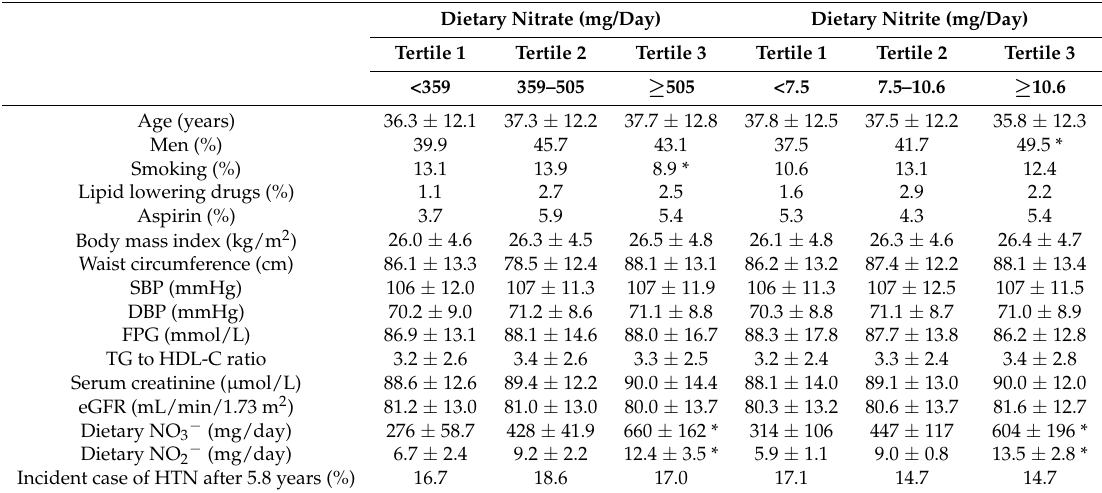
Table 1. Characteristics across tertile categories of dietary nitrate and nitrite intakes in hypertension (HTN)-free subjects at baseline ( n =